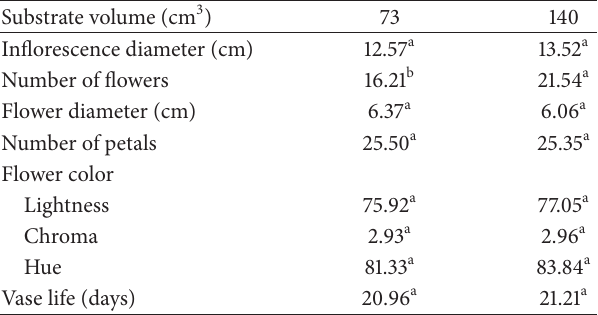
Table 9: Effect of substrate volumes on flowering characteristics of chrysanthemum.